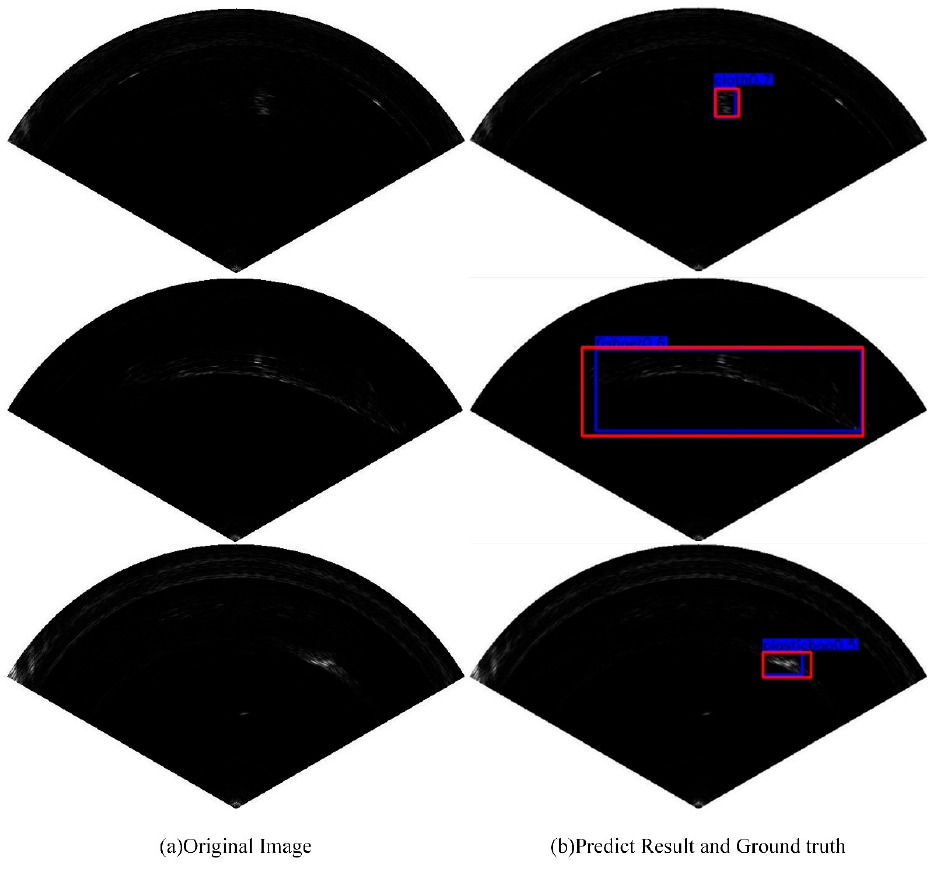
Figure 13. The detection results of FLS images. ( a ) Original FLS images with different objects. ( b ) Detection results of MRF-Net with blue boxes and ground truth with red boxes.